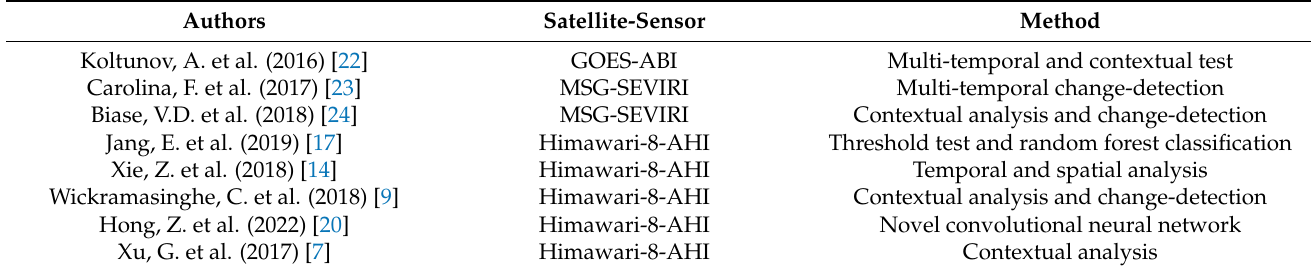
Table 1. Existing methods using geostationary